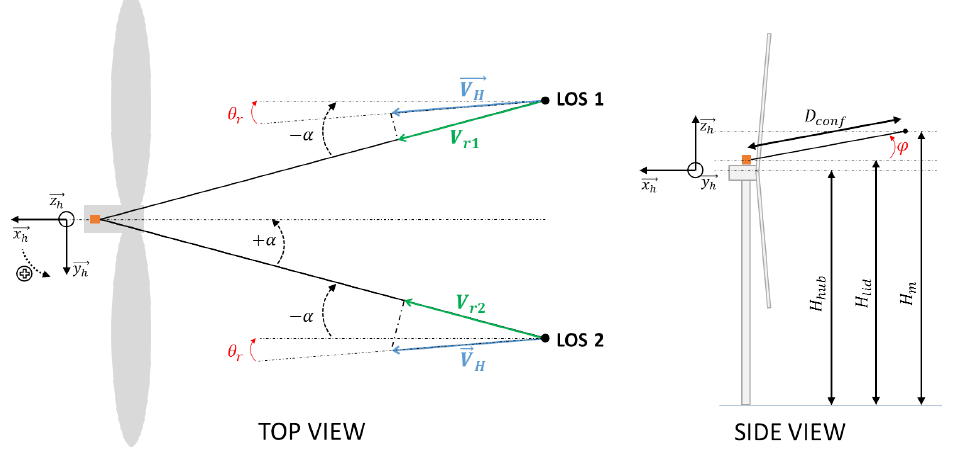
Figure 11. Two-beam nacelle lidar schematics for wind field